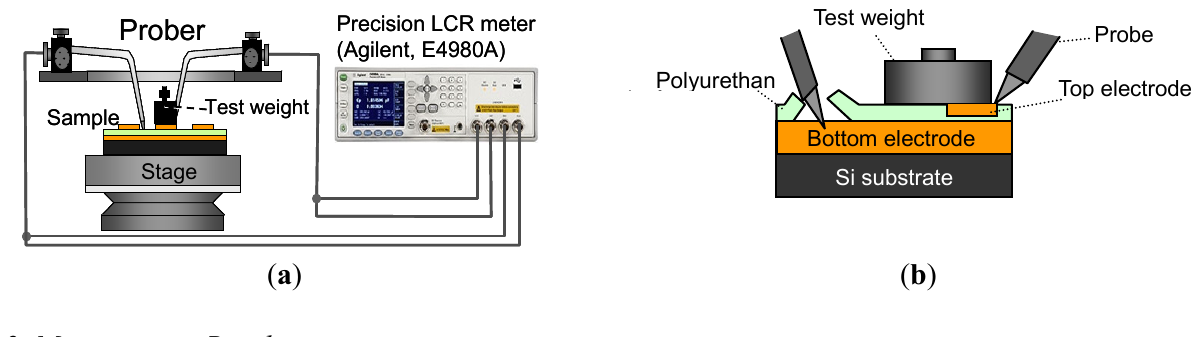
Figure 10. Measurement setup for characterizing fabricated tactile sensor.